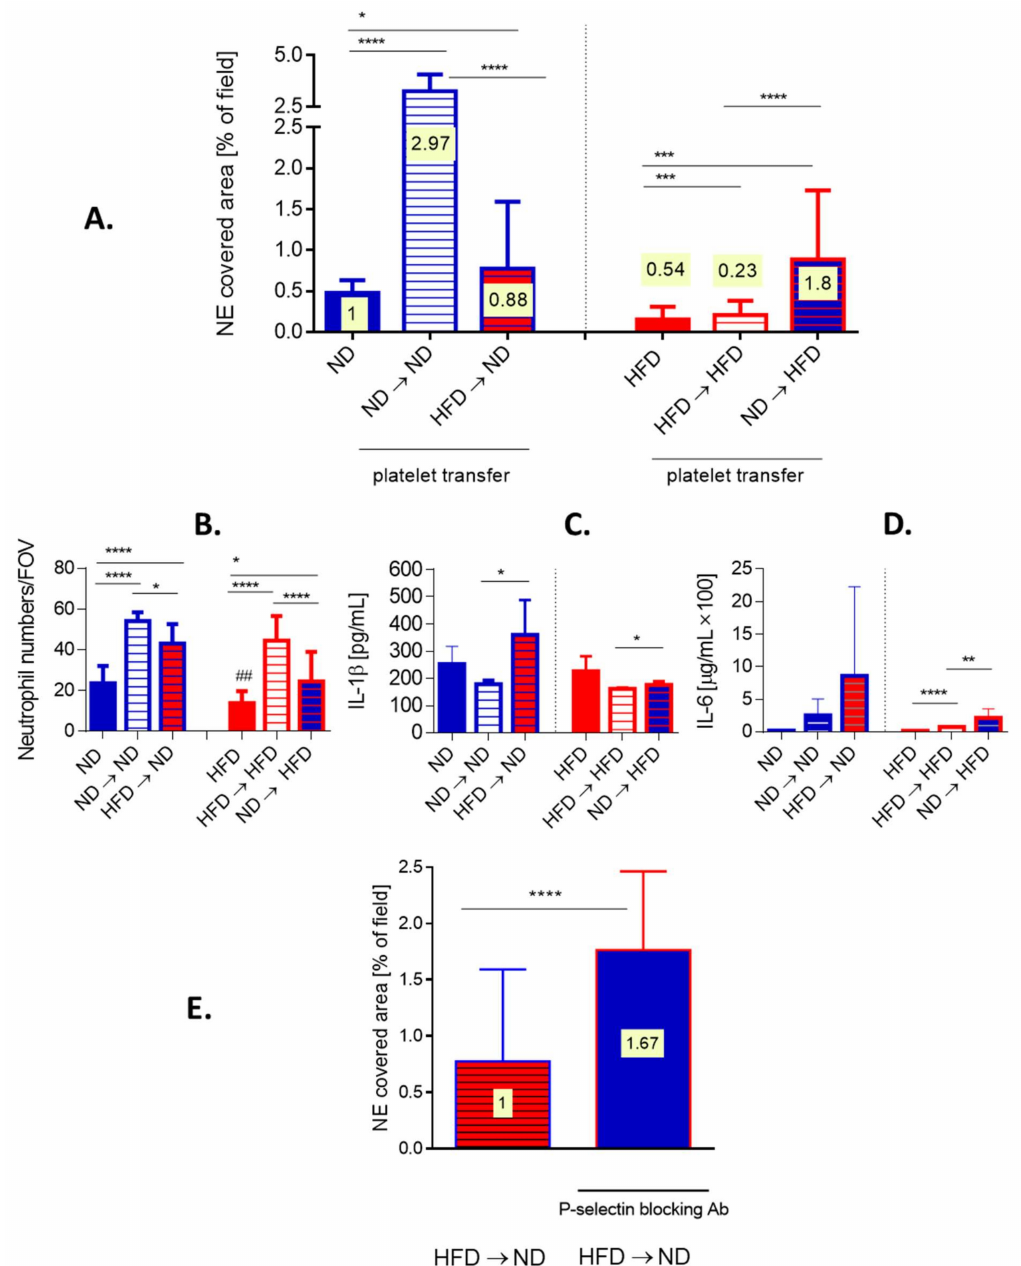
Figure 8. Effects of platelet transfer between lean (ND) and obese (HFD) mice on the formation of neutrophil extracellular traps (NETs), cytokine release and neutrophil accumulation in liver sinusoids. Platelets isolated from blood collected from healthy ND and HFD animals were subsequently intravenously (i.v.) injected into different recipients. Namely, platelets isolated from lean mice were injected into lean mice (ND → ND), platelets isolated from lean mice were injected into obese mice (ND → HFD), platelets isolated from obese mice were injected into lean mice (HFD → ND), and platelets isolated from obese mice were injected into obese mice (HFD → HFD). ( A ) neutrophil extracellular trap (NET) deposition in liver sinusoids and ( B ) neutrophil accumulation therein was estimated with intravital microscopy imaging (IVM), and IL-1b ( C ) and IL-6 ( D ) release into blood plasma by ELISAs. ( E ) Additionally, before transfer of platelets isolated from obese mice into lean mice (HFD → ND) they were incubated with P-selectin blocking antibody and NET formation was estimated with IVM. On bars in ( A ) and ( E ) ratio of NET-to-neutrophils is plotted (numbers on yellow background). Asterisks indicate significant differences between ND and HFD mice using unpaired two-tailed Student’s t -test (* p ≤ 0.05, ** p ≤ 0.01, *** p ≤ 0.001, **** p ≤ 0.0001). Data are shown as mean ± s.d.; n ≥ 3 per